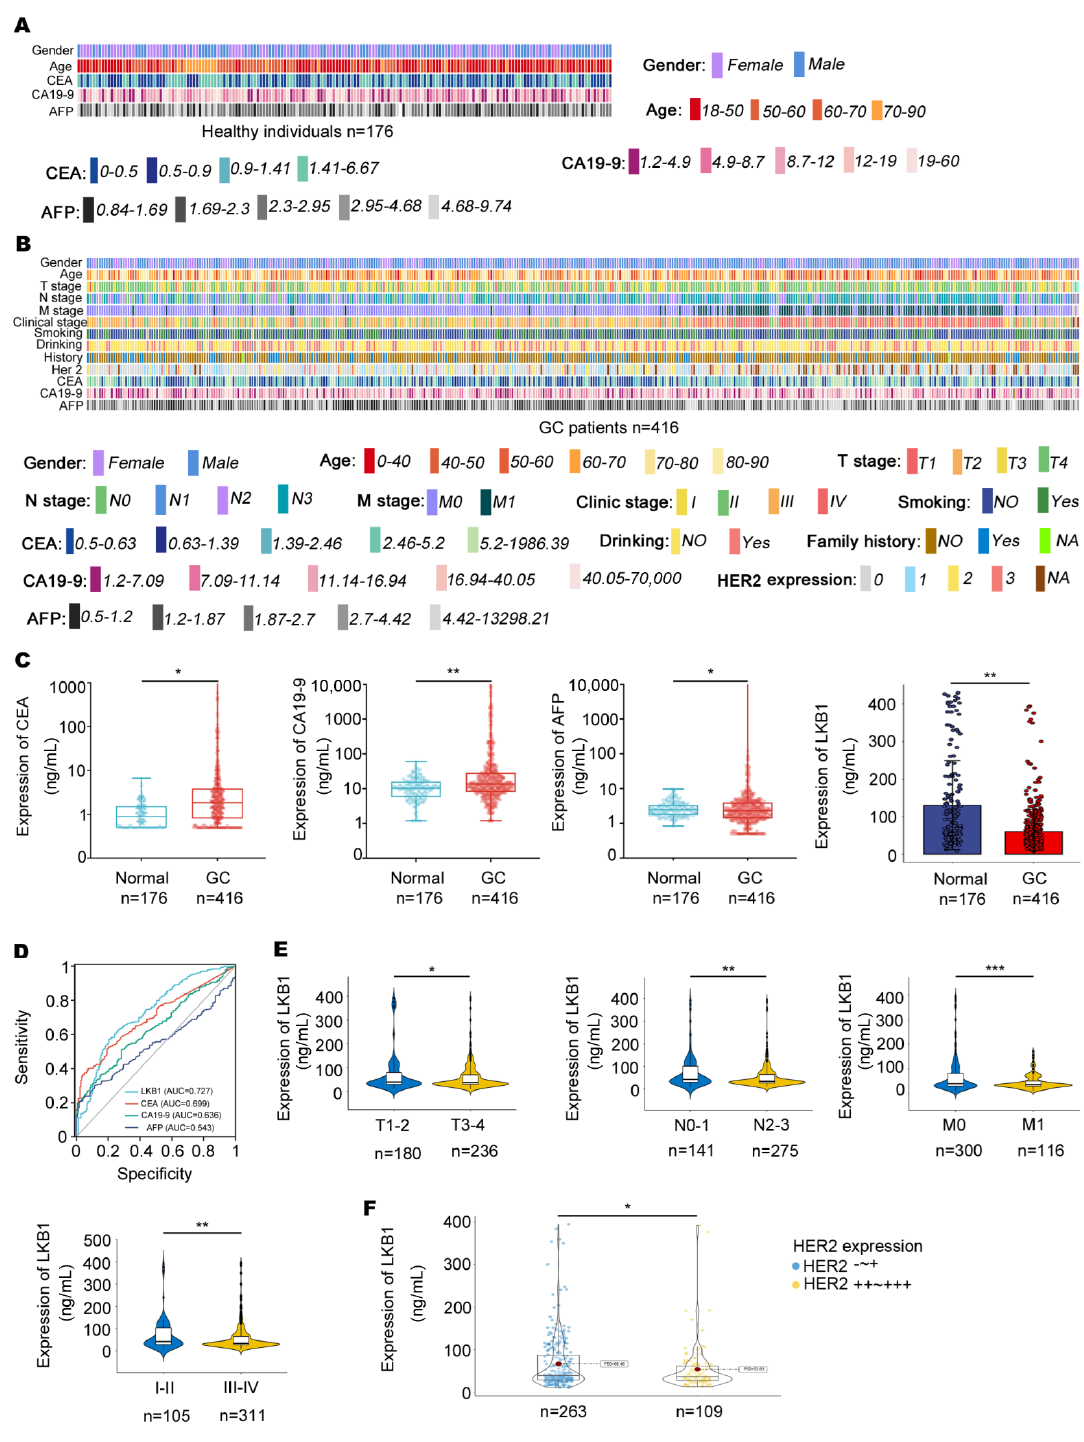
Figure 1. The relationships between LKB1 expression and clinical characteristics. ( A , B ), Clinical features in healthy individuals ( n = 176) and GC patients ( n = 416) were mapped using Python. ( C ), The expression of CEA, CA19 − 9, and AFP was measured in the serum of GC patients and healthy individuals. ( D ), Compared with CEA, CA19 − 9, and AFP, LKB1 had a higher sensitivity and specificity. ( E ), LKB1 expression was lower in stage N2 − 3, M1, and stage III − IV GC patients. ( F ), LKB1 was numerically highly expressed in HER2 negative GC patients. HER2-~+: HER2 negative GC patients. HER2++~+++: except for HER2 negative GC patients. Unpaired t -test, * p < 0.05, ** p < 0.01, *** p <